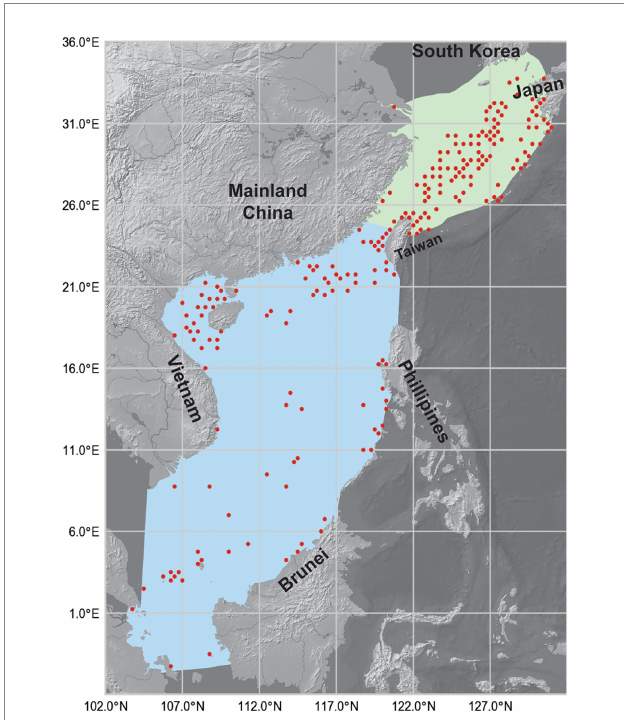
FIGURE 1 Map showing the South China Sea (SCS, blue areas) and the East China Sea (ECS, green areas). Red dots show the occurrence records of reef- associated fish from 1993 to 2019. The map has a spatial resolution of 0.25 ° × 0.25 ° . Shapefiles of the two LMEs were downloaded from the Large Marine Ecosystems Hub , and the background map was made with Natural Earth